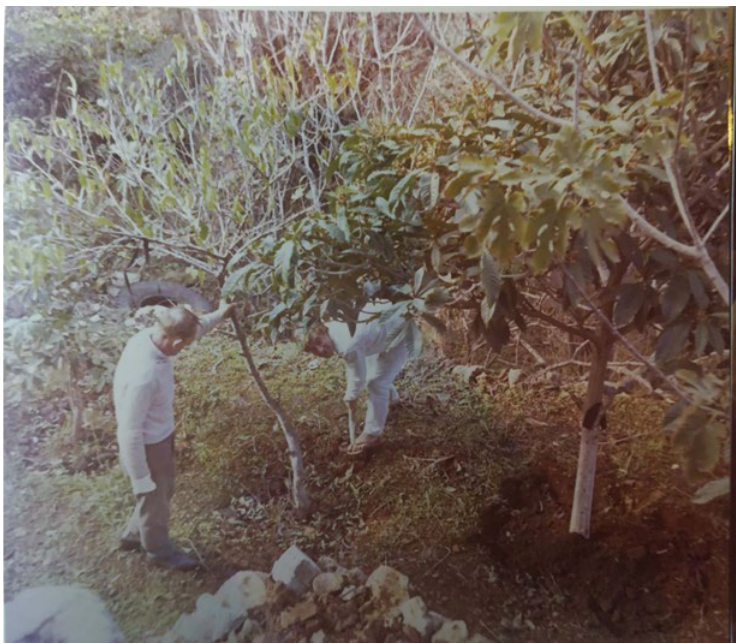
Figure 4 a former resident (Yitzhak Hoffer) and wife, under fruit trees in the Wadi, 1960s. Source: he Private Family collection of the Hoffer family and Ilan